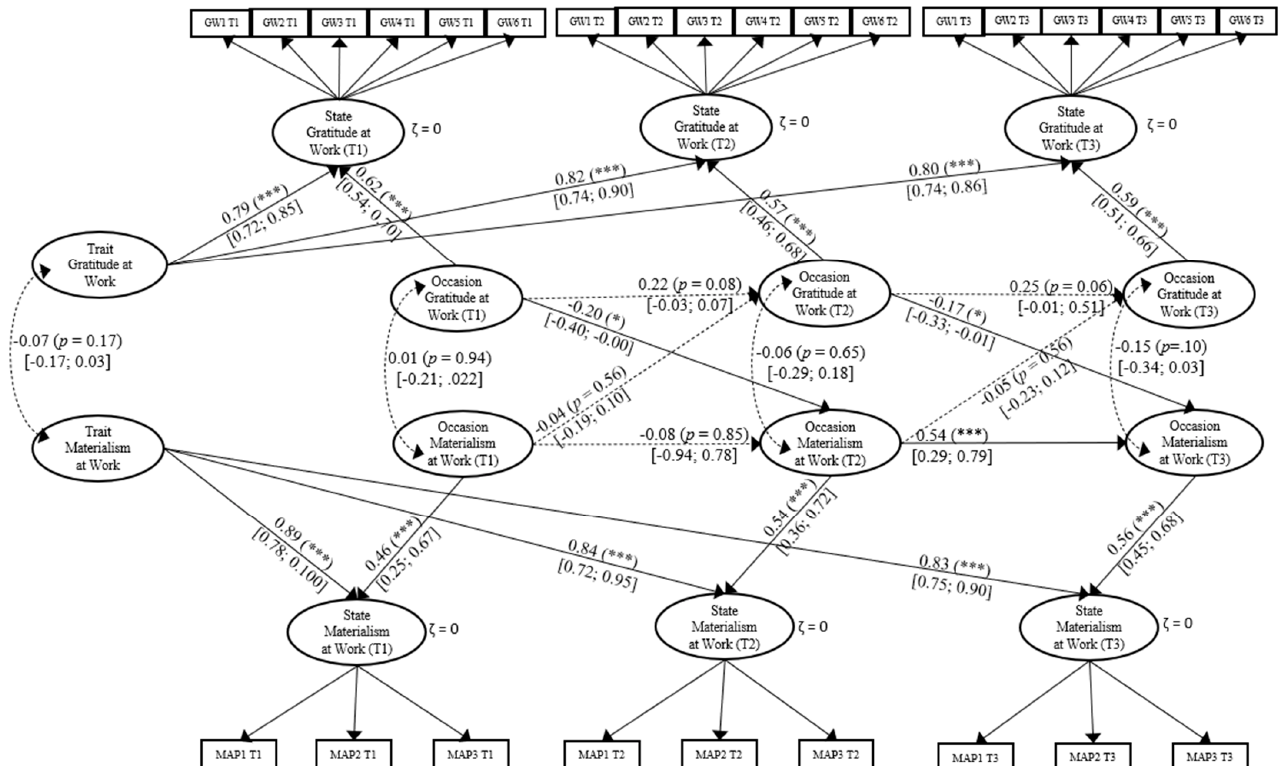
Figure 2. Model 2. Expanded Multivariate Trait-state-occasion (TSO) Model for the Associations Between Occasion Gratitude at Work and Occasion Materialism at Work. χ 2 (299) = 1374.453, p < 0.001; CFI = 0.91; RMSEA = 0.04. Note. All coefficients shown are standardized path. Error terms and factor loadings are not shown to enhance visual clarity. Loadings range all between 0.38 to 0.92 ( p < 0.001). T1: Time 1; T2: Time 2; T3: Time 3. GWi: Gratitude at work item i. MAPi: Parcels materialism at work item i. Solid lines = significant paths, Dotted lines = no significant paths. Confident intervals are reported in square brackets. *** p < 0.001; ** p < 0.01; * p < 0.05.